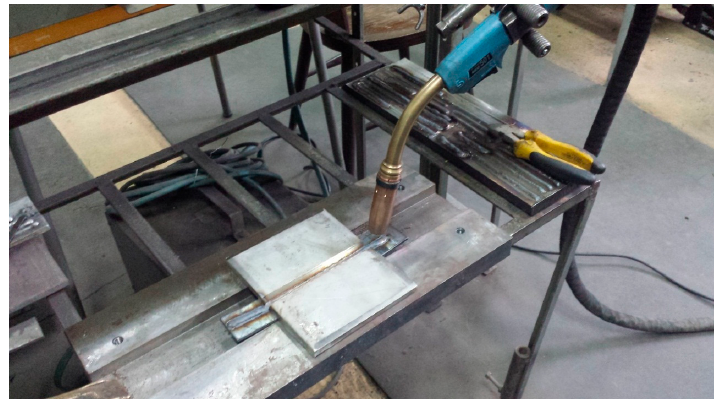
Figure 2. Components and welding torch.